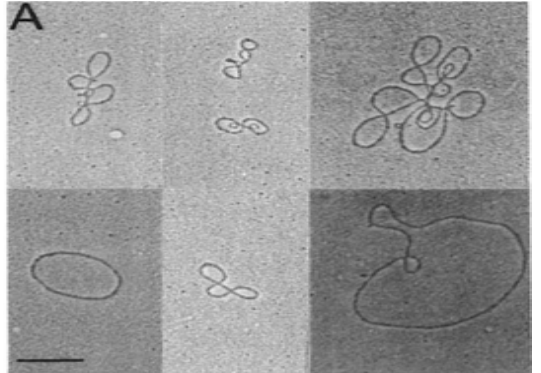
Figure 1. Electron micrograph of circular DNA purified from mouse thymocyte nuclei. These fragments were chown to contain T cell receptor gene sequences. The bar in the lower left represents 1kb [10].